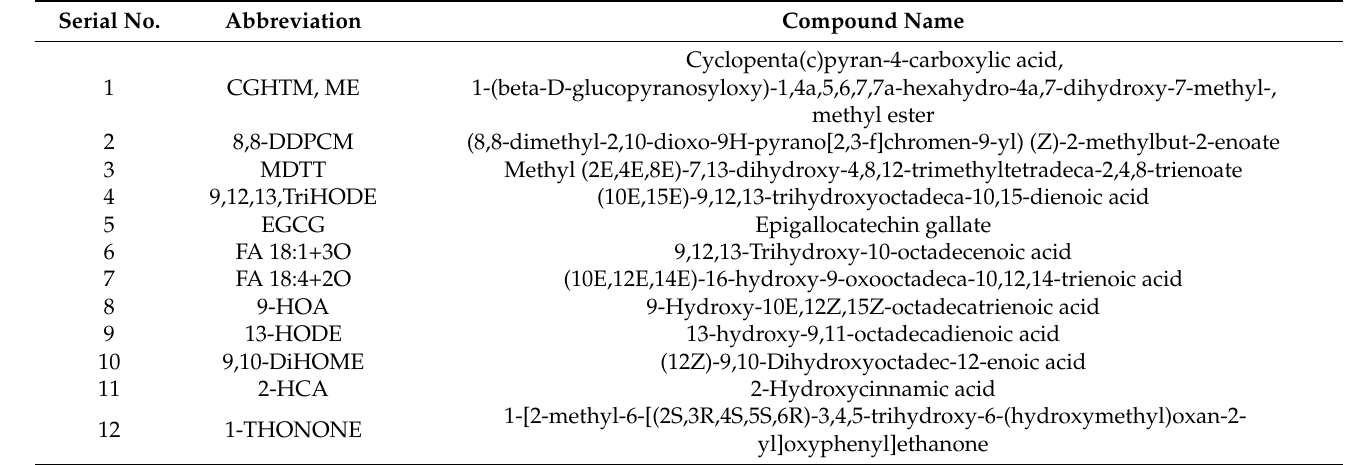
Table 4. List of some identified compounds abbreviated in Table 3.